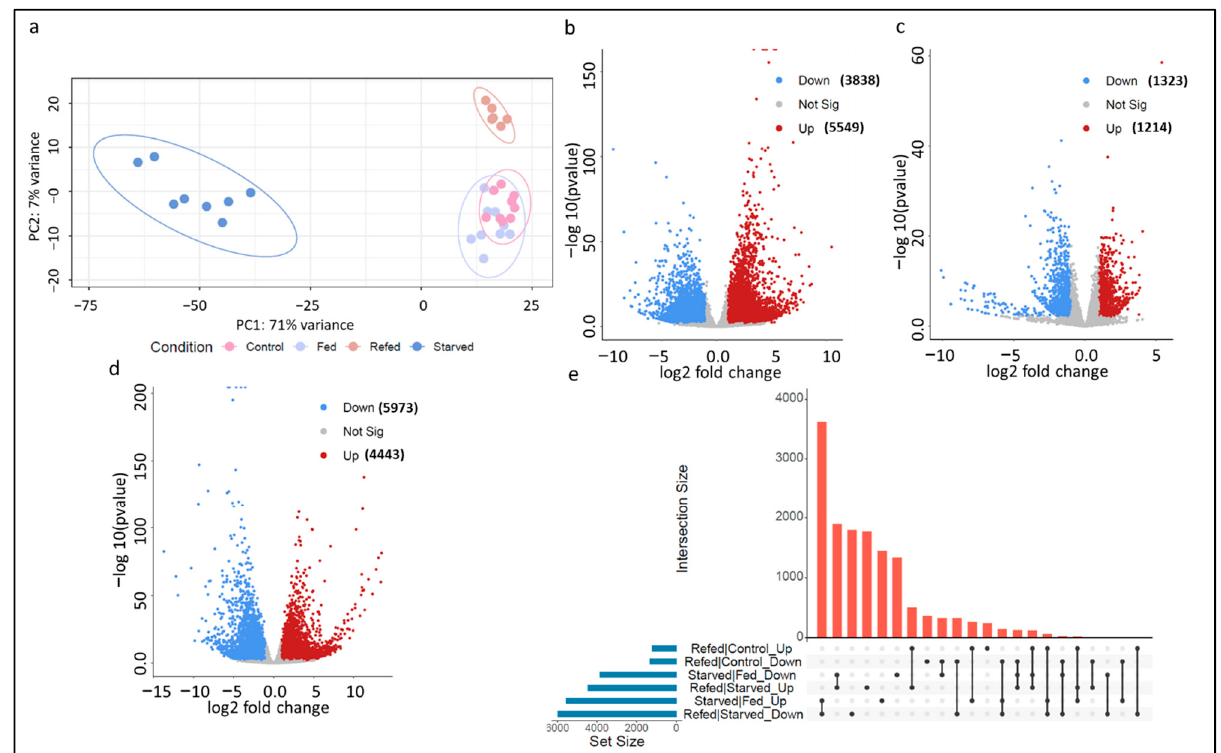
Figure 2. ( a ) Principal component analysis of tilapia transcripts obtained from 32 RNA-seq datasets generated from skeletal muscle of starved, fed, refed, and control fish. Each round dot represents a single RNA-seq dataset color-coded by treatment group. ( b – d ) Volcano plots showing the tilapia transcripts (mRNAs, lncRNAs, and microRNAs) differentially expressed between starved/fed, refed/control, and refed/starved groups. The red dots represent upregulated transcripts, whereas the blue dots represent downregulated transcripts at FDR < 0.05 and fold change > |2|. ( e ) UpSet chart showing the overlap among DE transcript sets obtained from the three pairwise comparisons. The horizontal bar plot represents the set sizes. The dot plot represents the set participation in the intersection, whereas the vertical bar plot represents the intersection size.